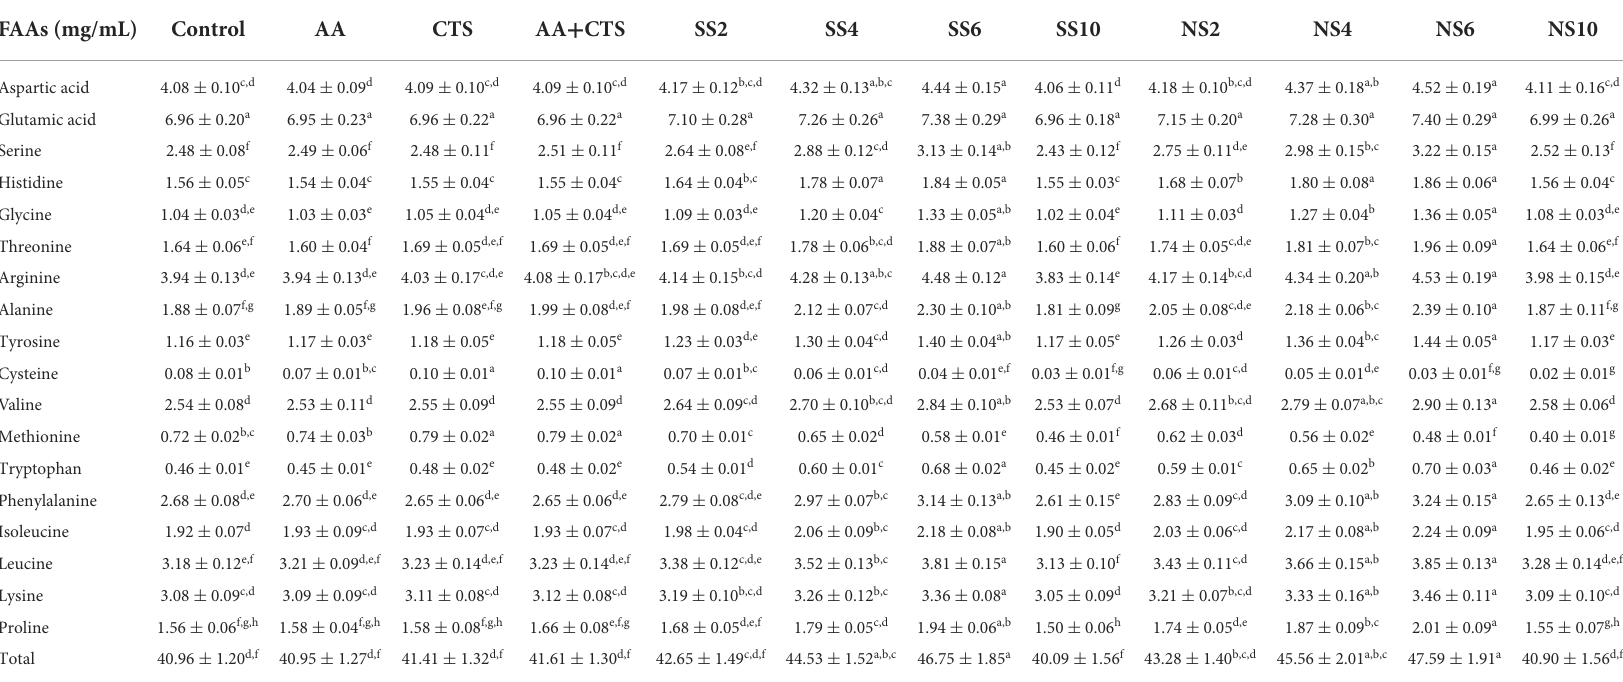
TABLE 3 Free amino acid compositions of soy